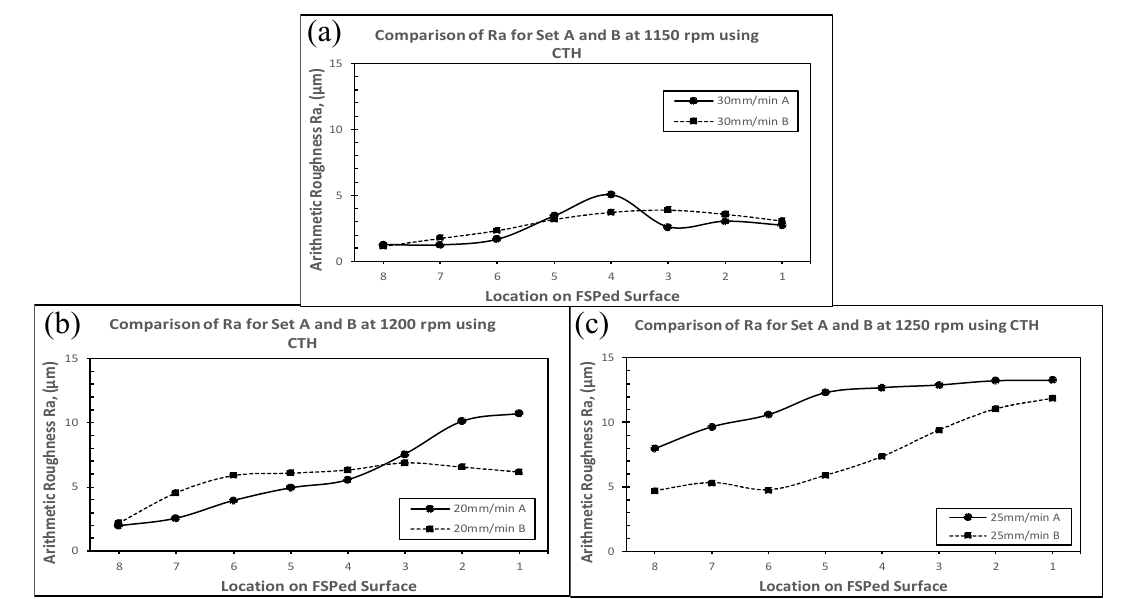
Figure 16. Comparison between Set A and B using CTH tool at, ( a ) 1150 rpm, 30 mm/min, ( b ) 1200 rpm, 20 mm/min, and ( c ) 1250 rpm, 25 mm/min.